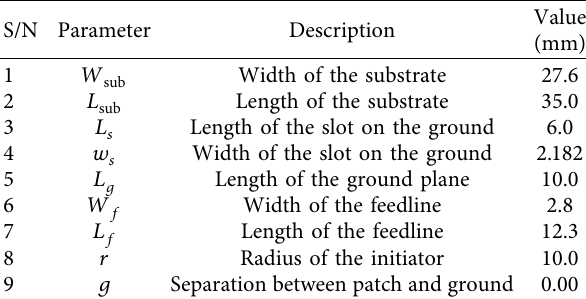
Figure 4: The VBi-UWBA separating the radiating patch from the substrate and ground plane. Table 2: VBi-UWBA optimal design parameters.